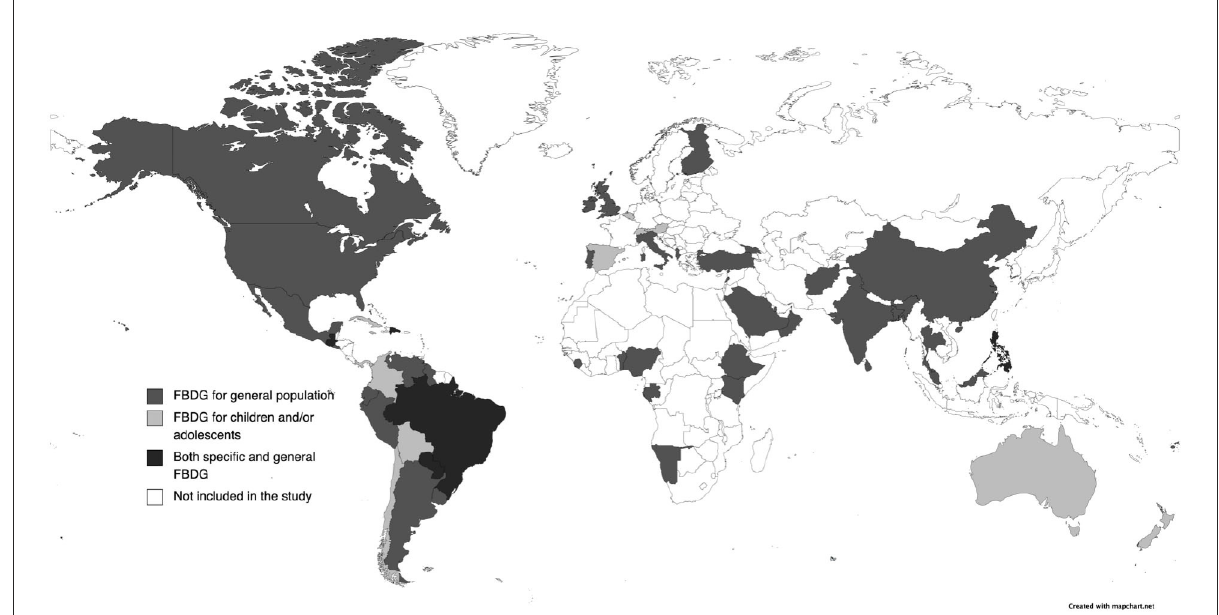
FIGURE3 Distribution of FBDG with content targeted at children and adolescents around the world.